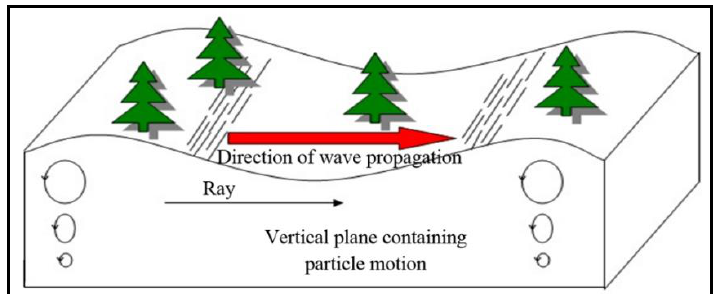
Figure 6. The behavior of particle elliptical motion in Rayleigh waves.